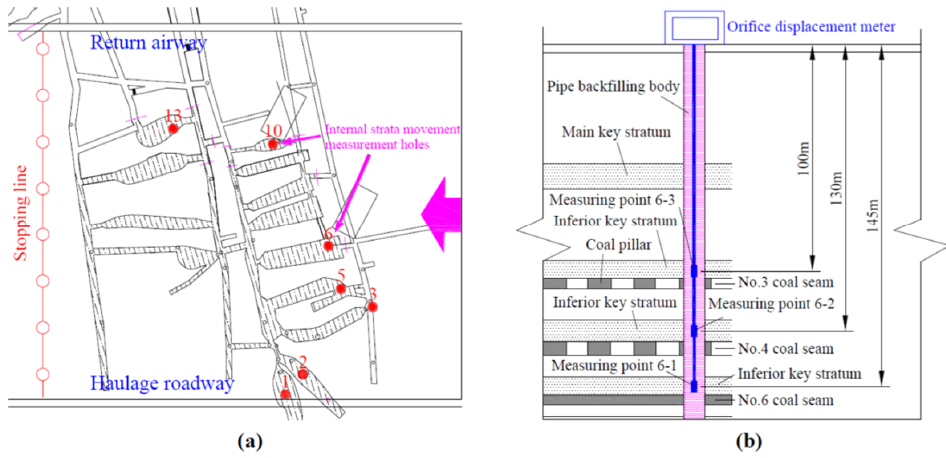
Figure 3. Internal strata movement installation plan of the longwall face. ( a ) Installation plan of the internal strata move- ment measurement and observation holes; ( b ) Diagram of the internal strata movement measurement hole No. 6 installa- tion.